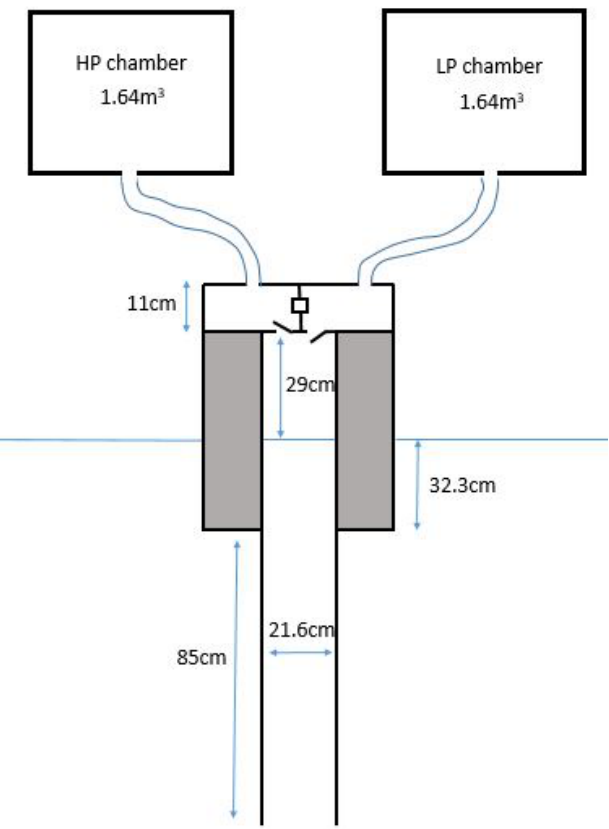
Figure 11. Schematic of the model-scale conventional OWC and Tupperwave